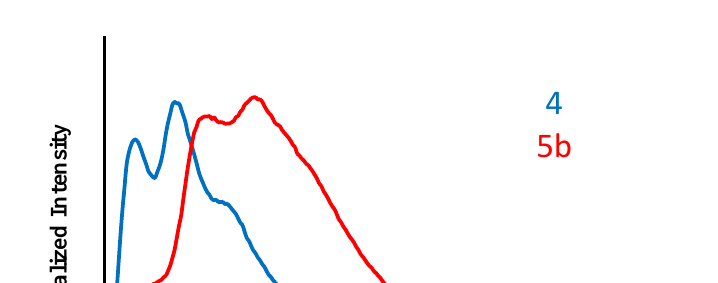
Figure 1. Absorption spectra of 4, 5a, and 5b in CHCl 3.